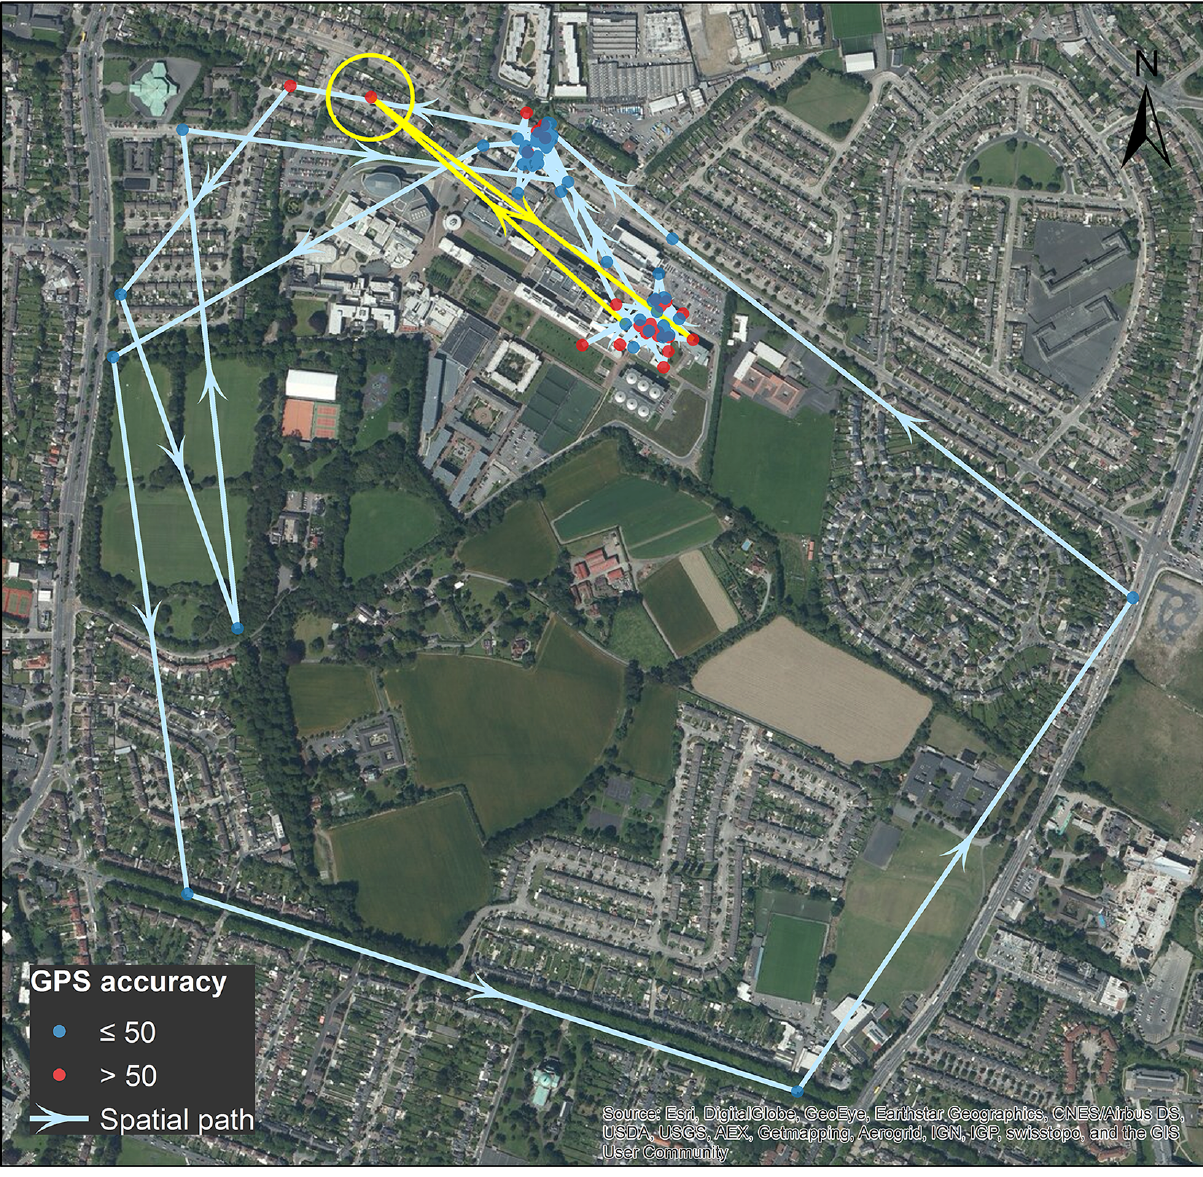
Figure 7. Example of participant location markers and interpolated spatial